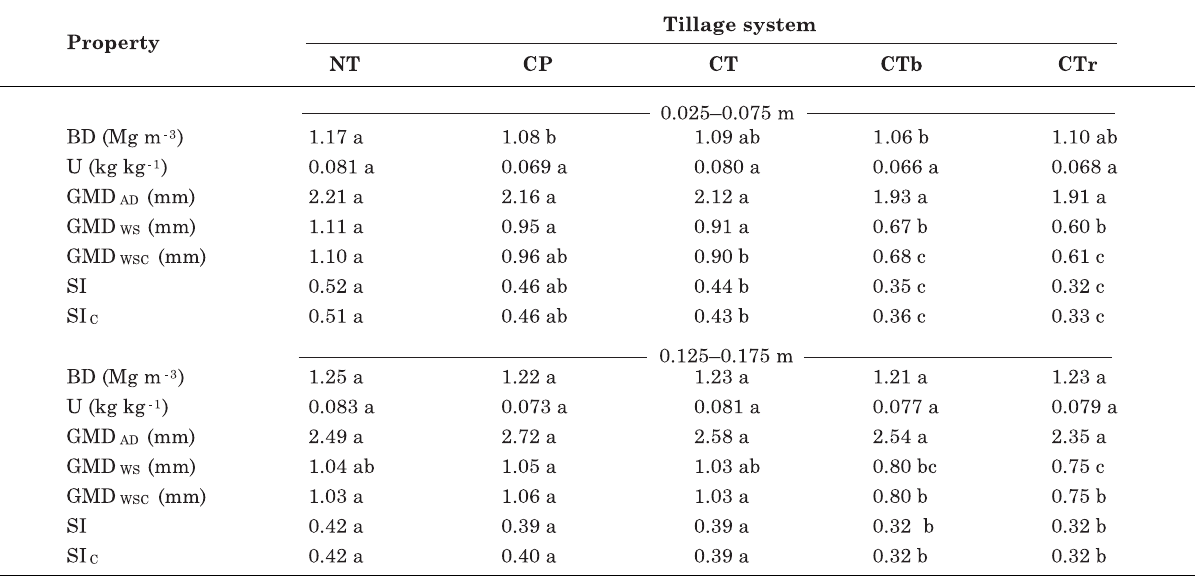
Table 5. Bulk density, gravimetric moisture at time of water aggregate stability test, size distribution and aggregate stability indexes at two layers and in five tillage systems (averaged across sampling dates performed during the tenth year)